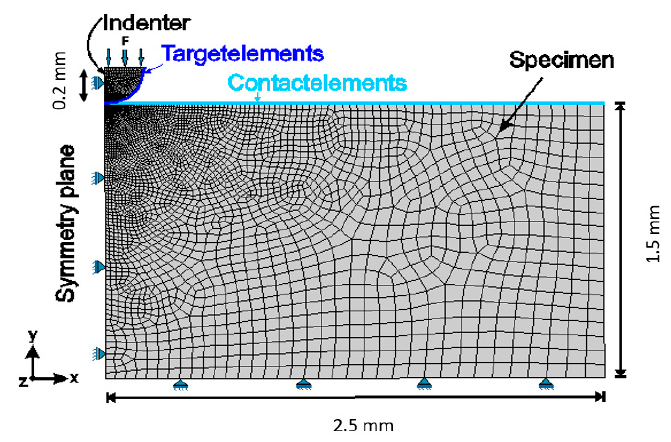
Figure 2. Geometry of the simulation model of IIT.